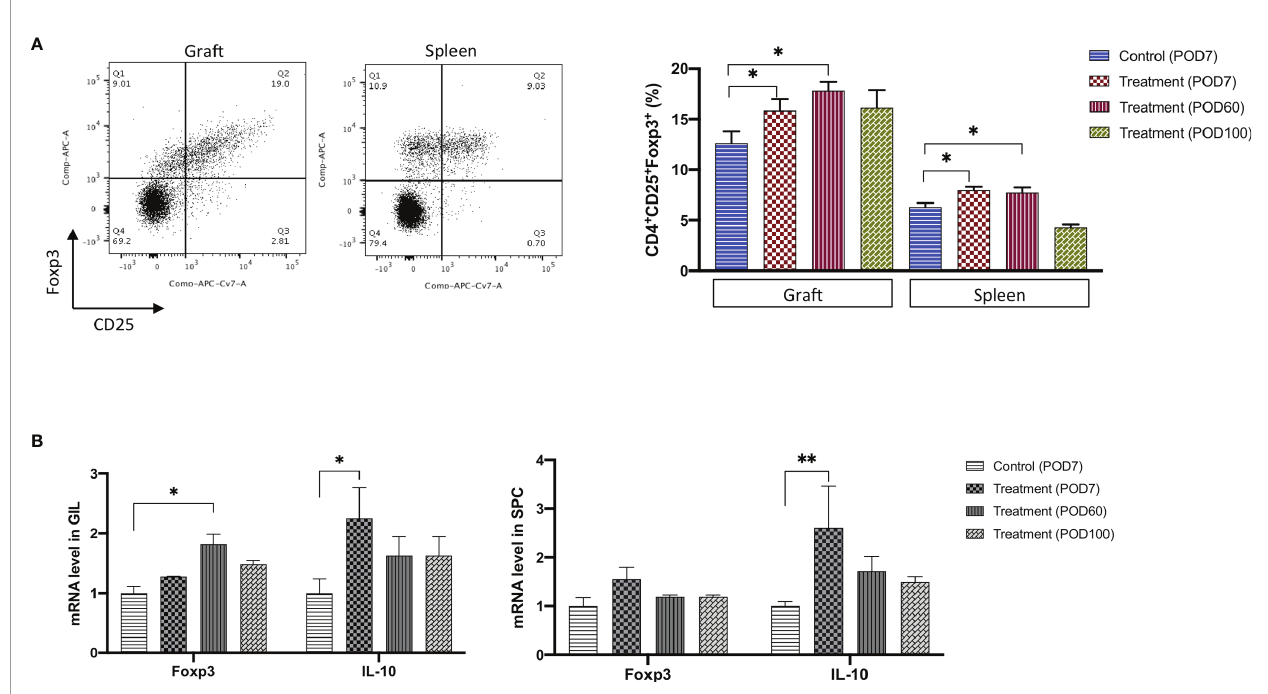
FIGURE 4 | The Treg cell number and the related mRNA expression were signi fi cantly increased in graft and spleen of the FR70-treated recipients. (A) Grafts and spleens were collected on POD7, 60 and 100. The representative data from Foxp3 and CD25 staining with speci fi c antibodies are presented (left panel). The percentage of CD25 + Foxp3 + cells among the CD4 + GILs and SPCs was determined by FCM (right panel, n = 4 – 8 mice for each group, mean ± SEM, pooled from two independent experiments). Gating strategy is presented in Supplementary Figure 3B . Statistical analysis was determined by one-way ANOVA and Tukey ’ s test. *p < 0.05. (B) Quantitative RT-PCR of the Foxp3 and IL-10 mRNA levels in GILs and SPCs collected at POD7, 60 and 100 (n = 4 – 5 mice for each group, mean ± SEM, pooled from three independent experiments with three biological replicates). Statistical analysis was determined by one-way ANOVA and Tukey ’ s test. *p < 0.05, **p <